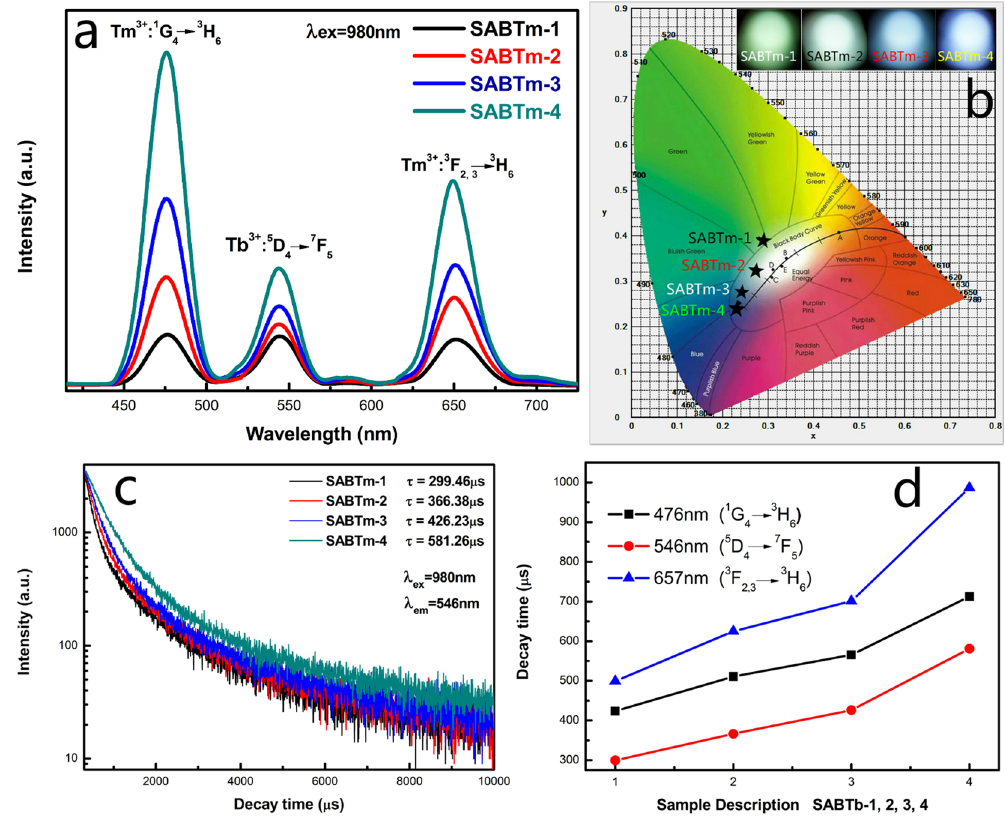
Figure 6. ( a ) The UEC emission spectra of SABTm-1, SABTm-2, SABTm-3 and SABTm-4 glass-ceramics. ( b ) CIE (X, Y) coordinate diagram showing chromaticity points of Tb 3 + and Tm 3 + luminescence in the glass- ceramics. ( c ) Fluorescence decay curves of Tb 3 + ions at 546 nm in the SABTm glass-ceramics under 980 nm excitation. ( d ) Decay behavior of 5 D 4 , 1 G 4 and 3 F 2,3 levels for the SABTm